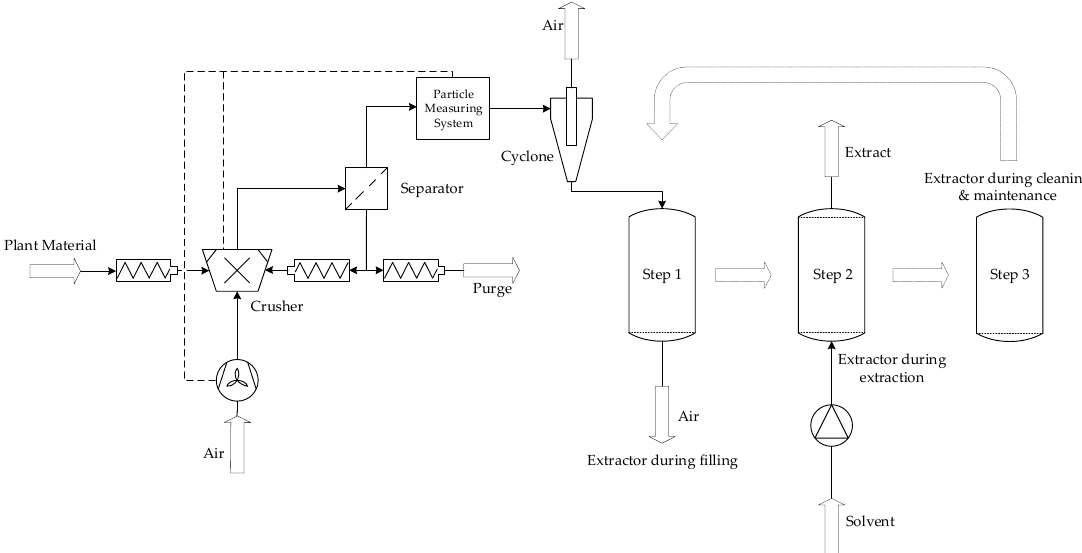
Figure 13. Process proposal for the Integrated Continuous Pretreatment and Extraction (iCPE).